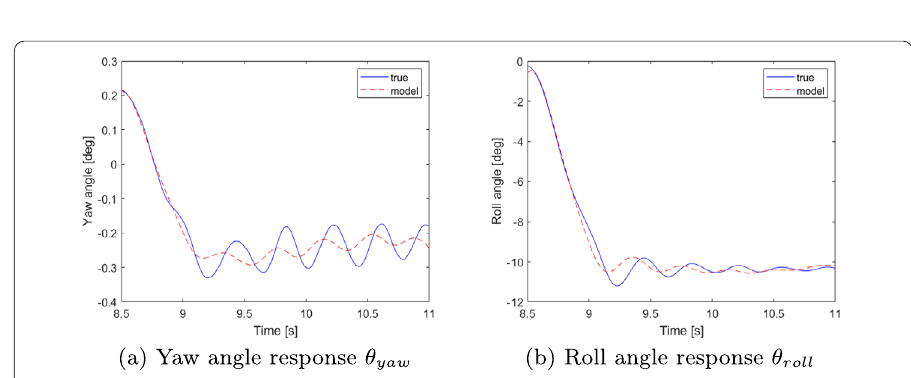
Figure 26 Yaw and roll angle responses against the identified linear model